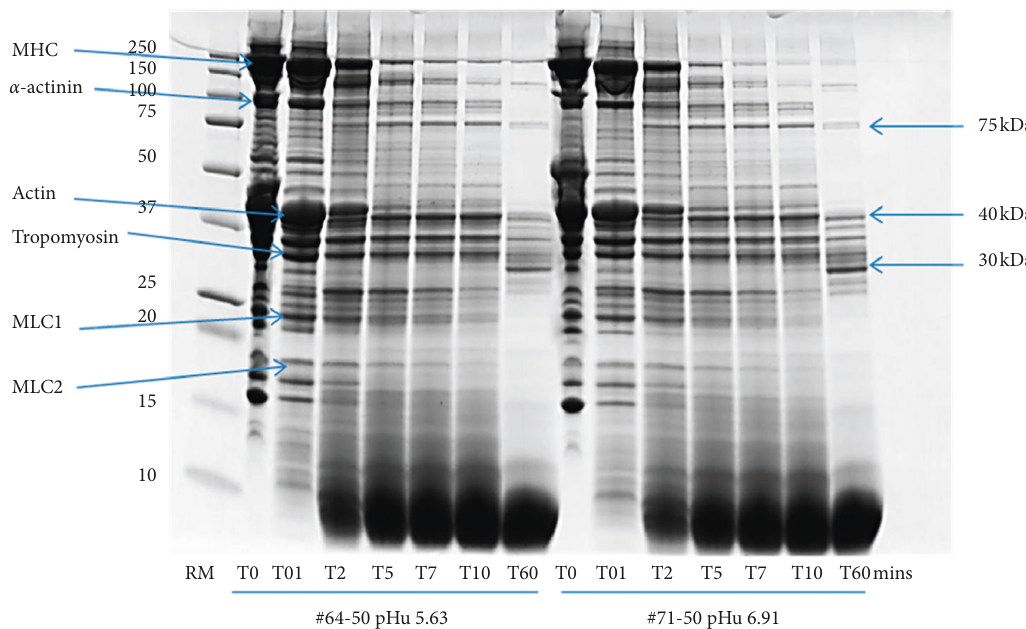
Figure 5: Experiment 2: SDS PAGE showing the effect of ultimate pH (pHu) on the digestibility of protein in cooked M. longissimus dorsi from bull beef. Results during the gastric phase for the sampling timepoint from two of the seven animals in this experiment are presented as